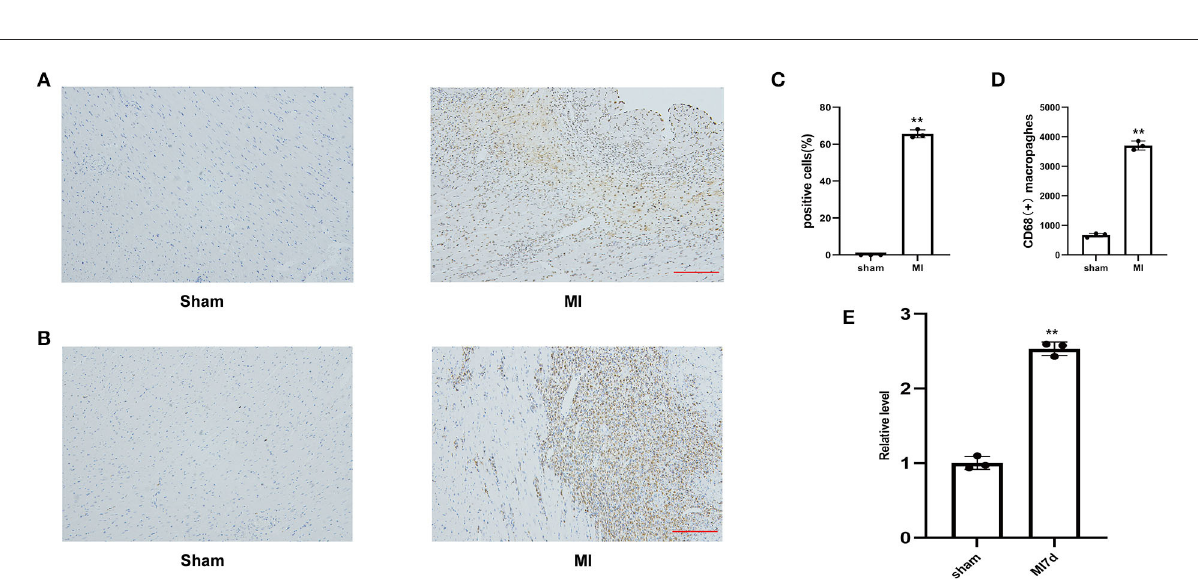
+ shCtrl group (Figures 6E–G). In addition, compared with the MI + shCtrl group, the MI + shlncRNA group had downregulated the LF/HF ratio (Figures 6H,